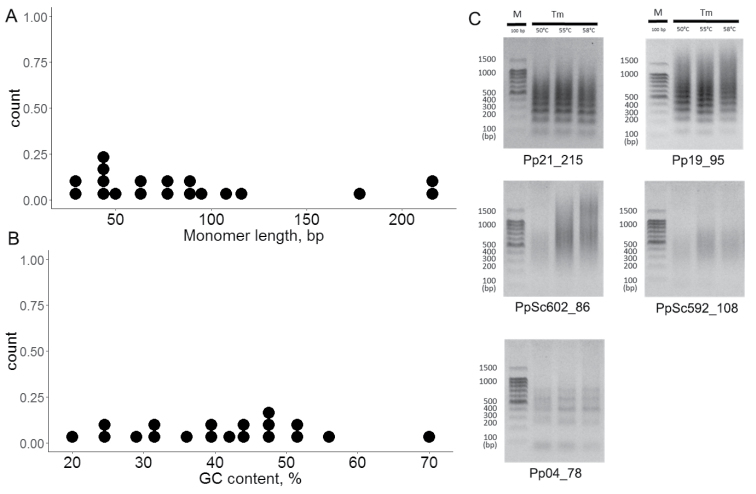
Features of 19 TRs. A Monomer length distribution B GC content distribution C Electrophoresis of PCR products from 5 TRs.